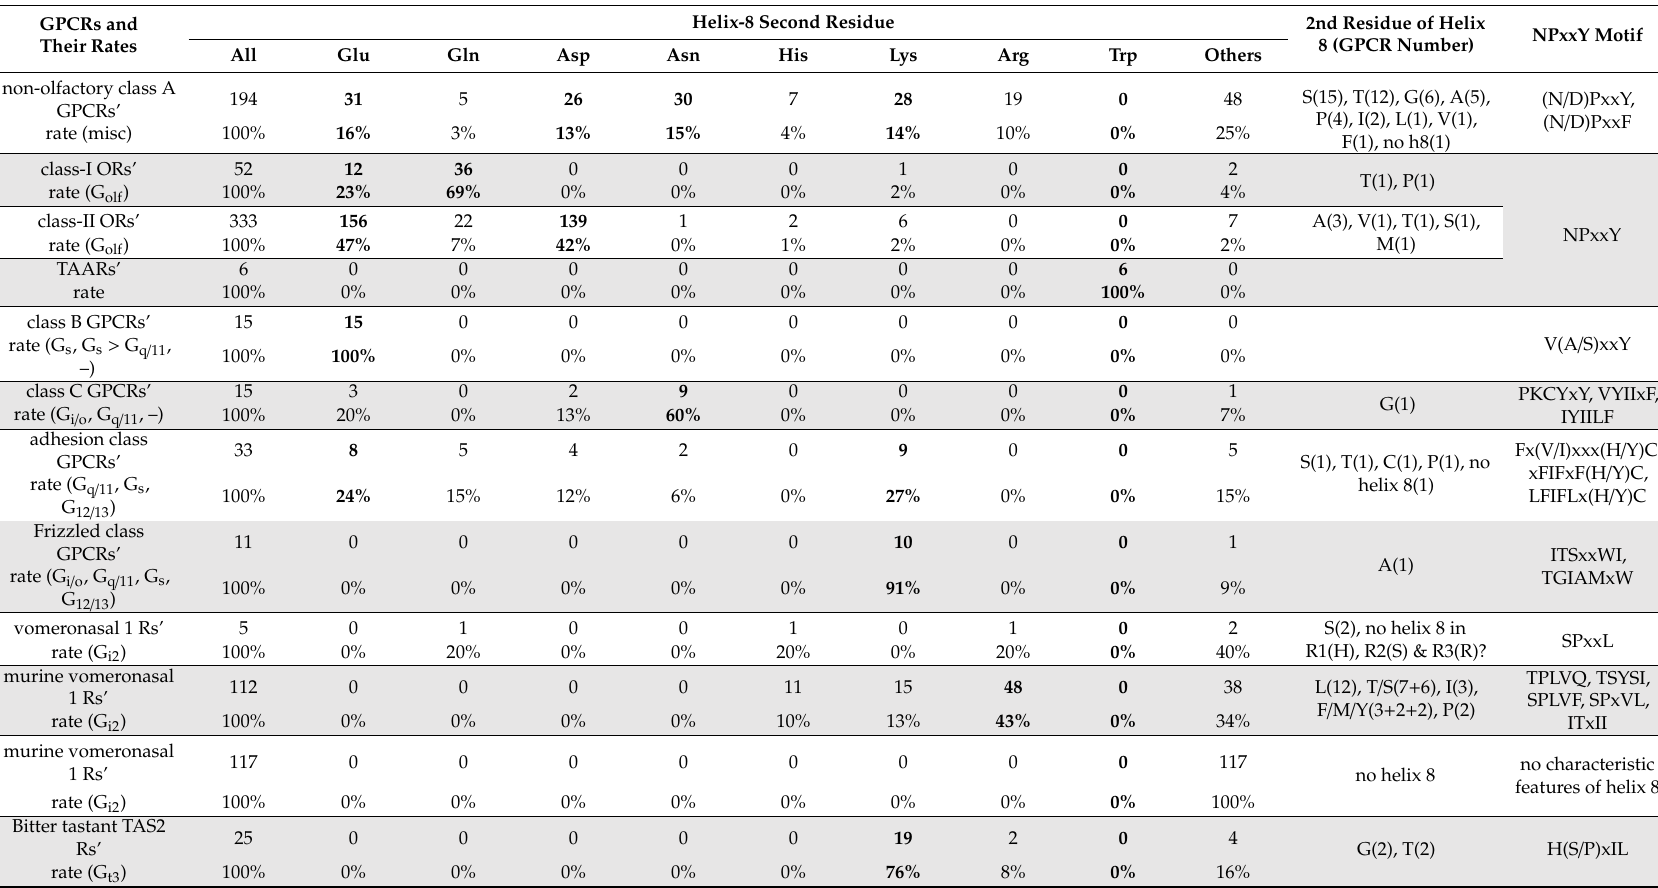
Table 2. Classification of olfactory receptors and other GPCRs by helix-8-second residues and subtypes of G proteins (modified from [9,10]). GPCRs and Their